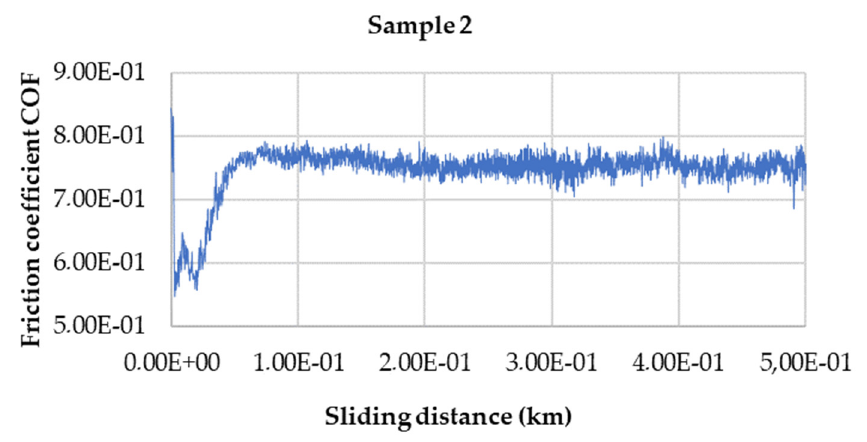
9 of 16 Figure 6. Course of COF for Ni-Co coatings (Sample 1) deposited at 1 A dm − 2 .